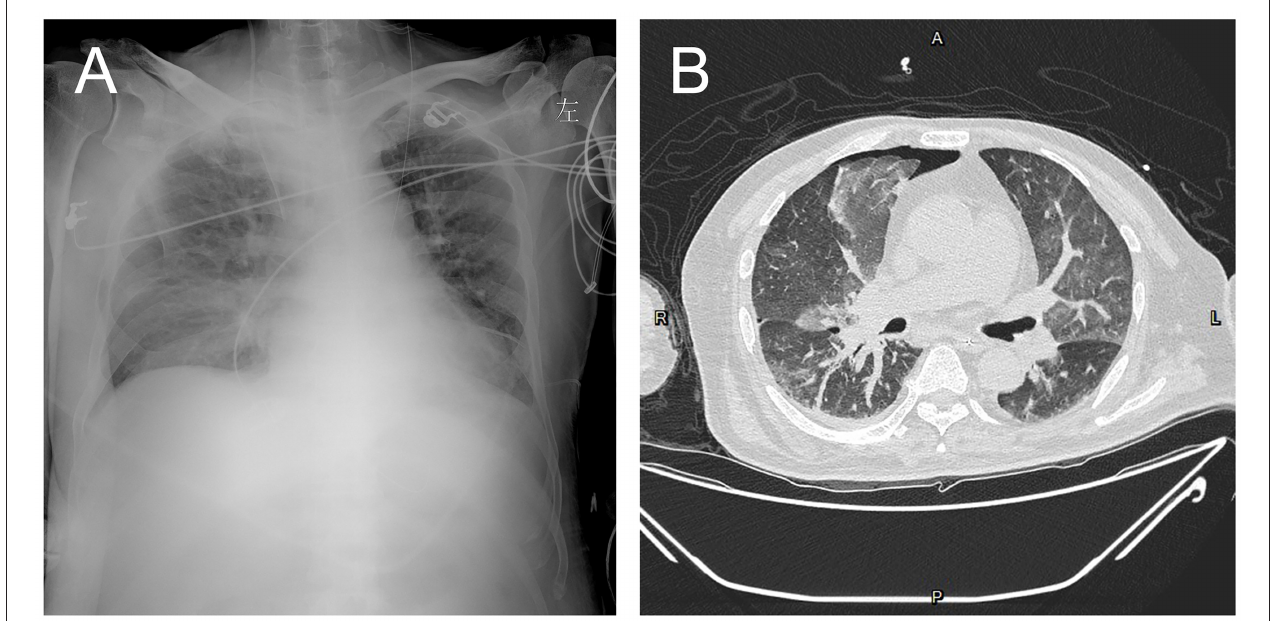
FIGURE 1 | The patients’ chest X-ray on July 1st (A) and CT on July 16th (B) .